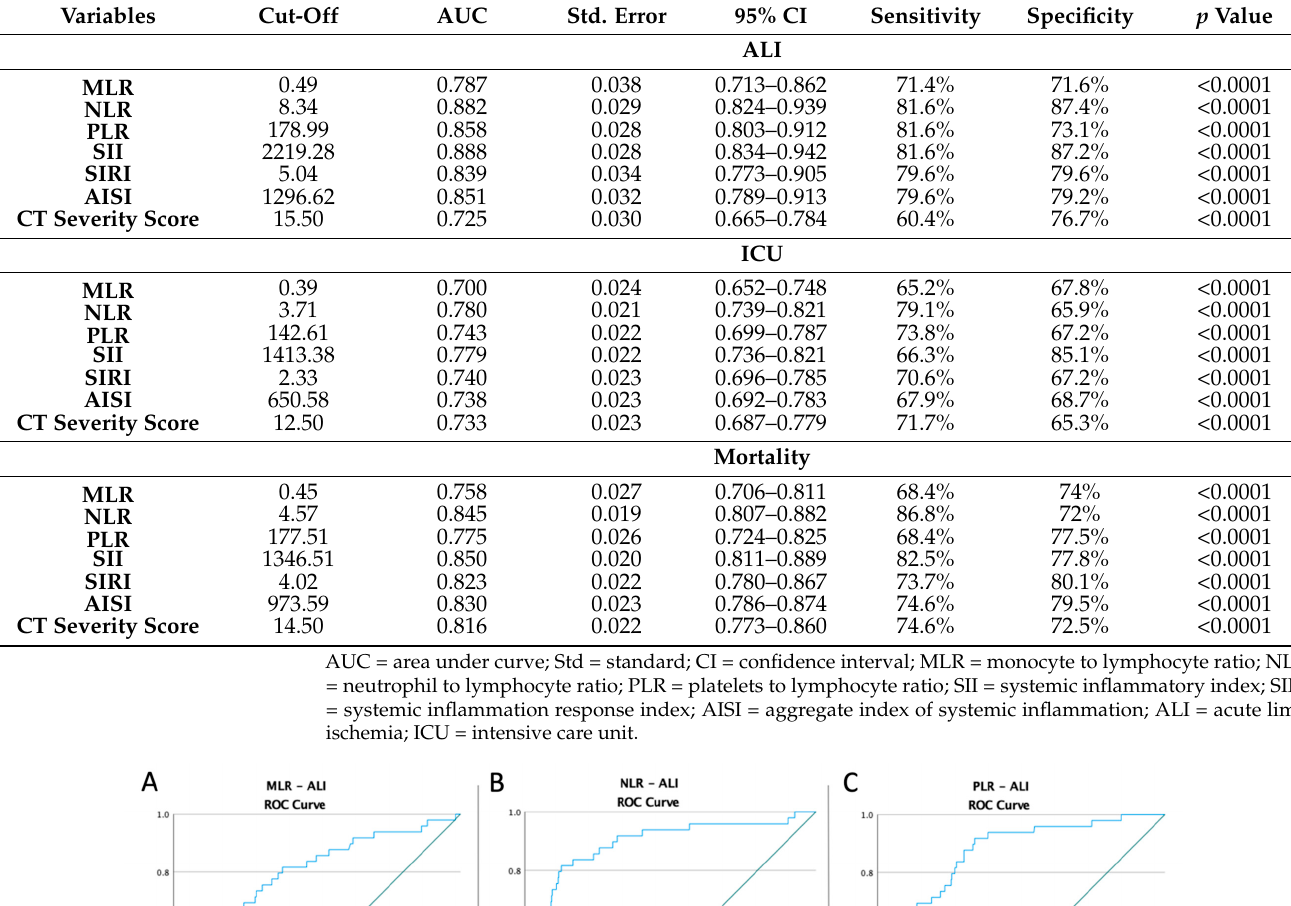
Table 3. ROC curves, optimal cut-off value, AUC, and predictive accuracy of inflammatory markers (MLR, NLR, PLR, SII, SIRI, and AISI) and the CT Severity Score.